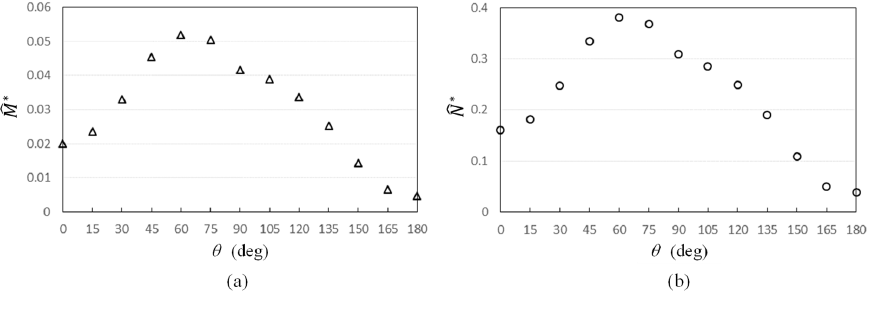
Figure 9. Variation of 𝑀(cid:3553) ∗ and 𝑁(cid:3553) ∗ with wind direction θ : ( a ) 𝑀(cid:3553) ∗ ; ( b ) 𝑁(cid:3553) ∗